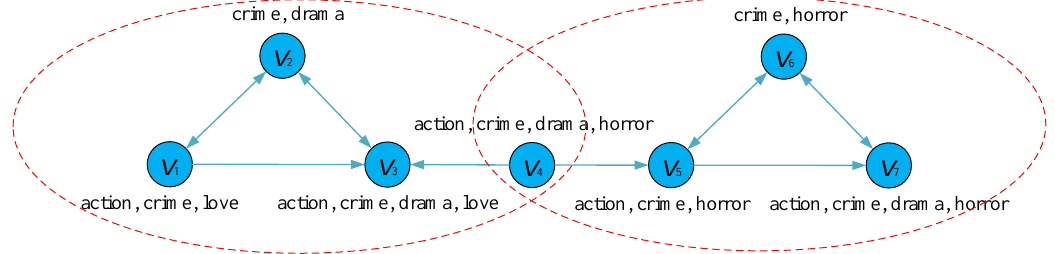
Figure 2. An example of community detection in an attributed network. The red dotted lines represent the boundaries of the communities. Texts next to nodes represent their node